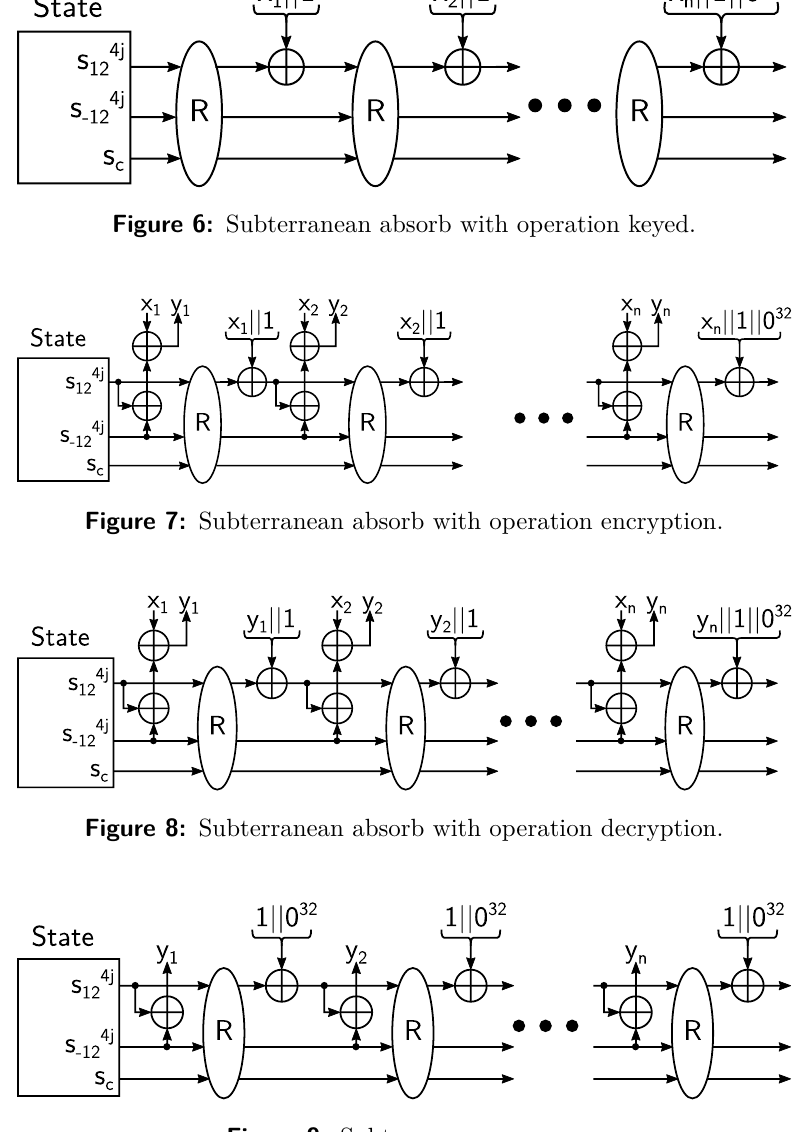
Figure 9: Subterranean